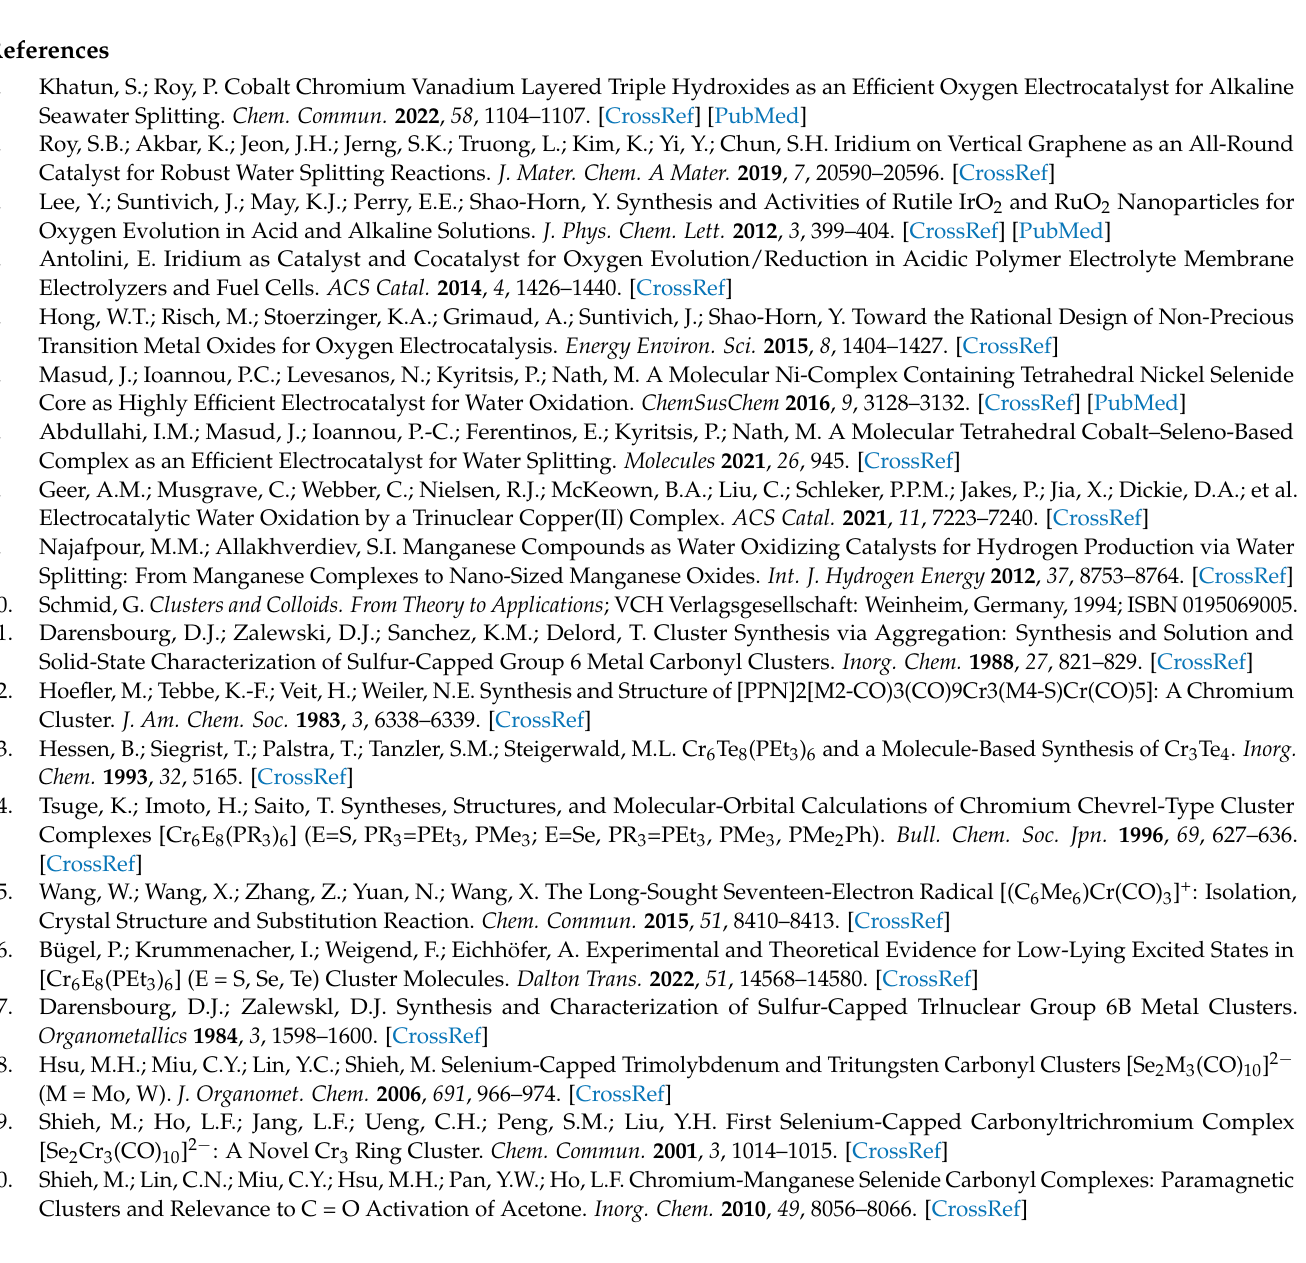
Table S2: Comparison of the OER performances in an alkaline electrolyte (overpotential at 10 mA cm − 2 current density, and Tafel slope) of recently published chromium-based catalysts with our work. Refs. [16,25,45–52] are cited in the supplementary